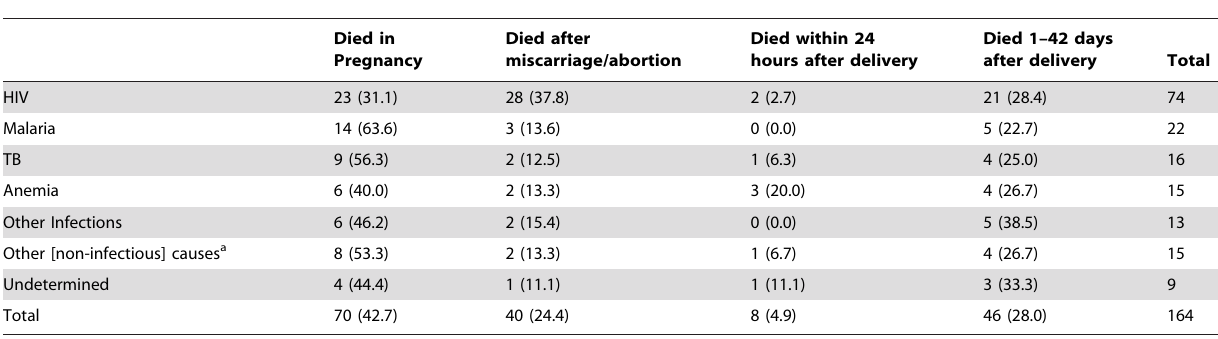
Table 3. Distribution of indirect causes of death by phase of pregnancy.